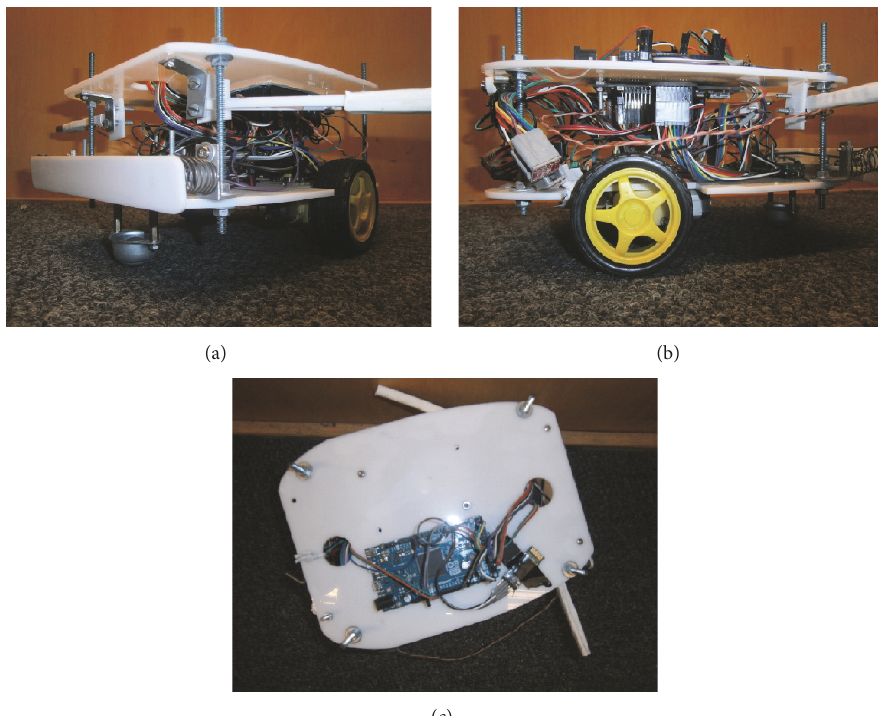
Figure 6: Constitutive parts of robot: (a, b) left and right sides views; (c) top view of the robot: observe the left tilt sensor that indicates wall